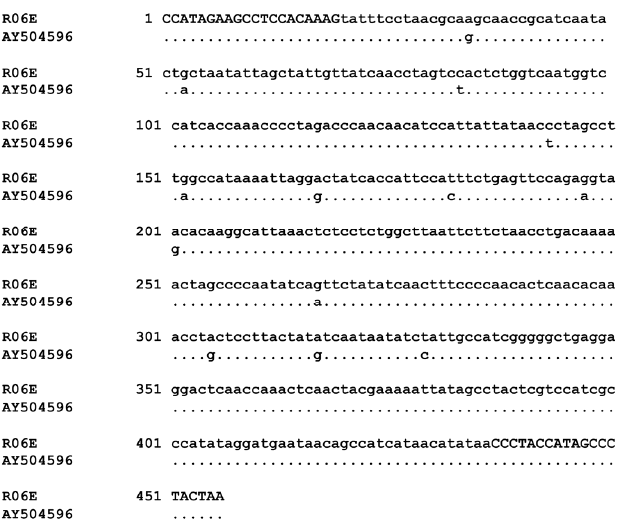
sequence to the GenBank entry are also present in the R05R and R05T sister cell lines. Capital letters: primer